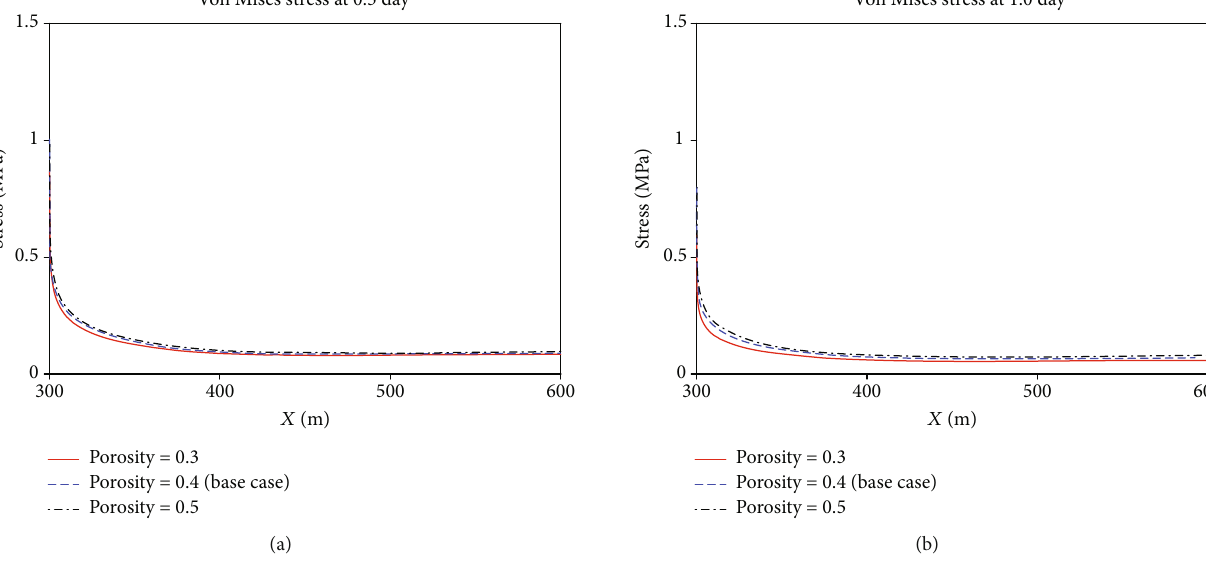
Figure 13: 1D stress distribution from the wellbore to the domain boundary along Y = 300 m after (a) 0.5 day and (b) 1 day of shallow water fl ow for porosity